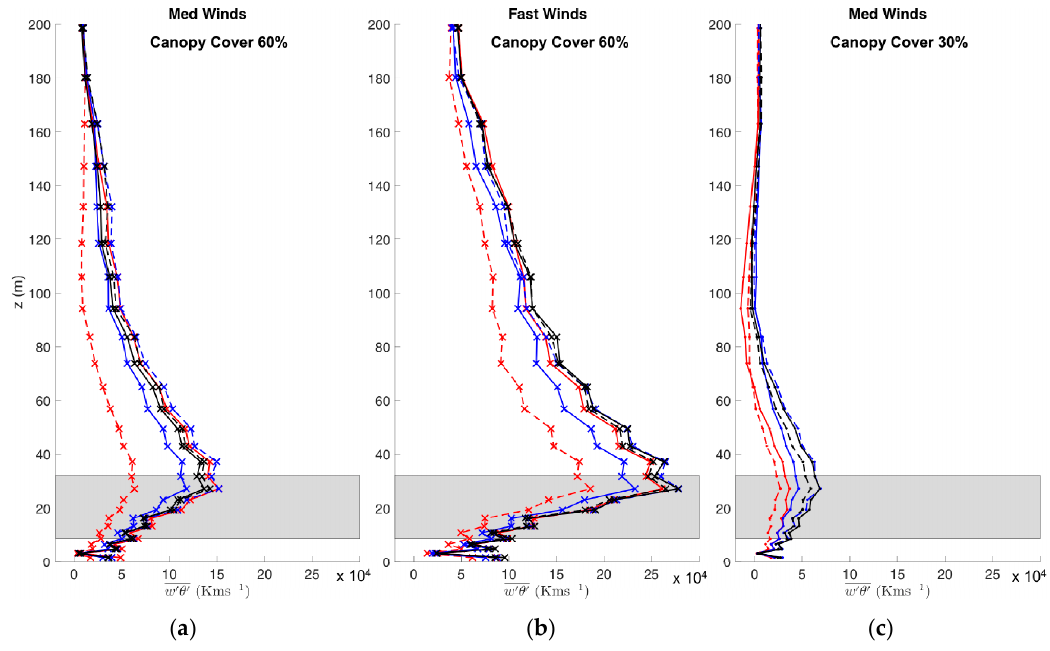
Figure 8. Spatially and temporally averaged vertical profiles characterizing the kinematic heat flux, W (cid:48) θ (cid:48) , (on the x axis) with increasing height ( y axis), for ( a ) 60% canopy cover, medium winds cases, ( b ) 60% canopy cover, fast winds cases, and ( c ) 30% canopy cover, medium winds cases. Red lines show profiles for high aggregation cases, blue lines show moderate aggregation cases, and black lines show low aggregation cases. All three plots share the same x and y axes. The spread between profile line pairs (same color) illustrates differences between spatial replicates. Across all three subplots differences are highest for the high aggregation cases (red lines); differences are most pronounced for medium wind, high canopy cover cases ( a ) fuel spatial patterns; differences between replicates are highest for high aggregation cases.